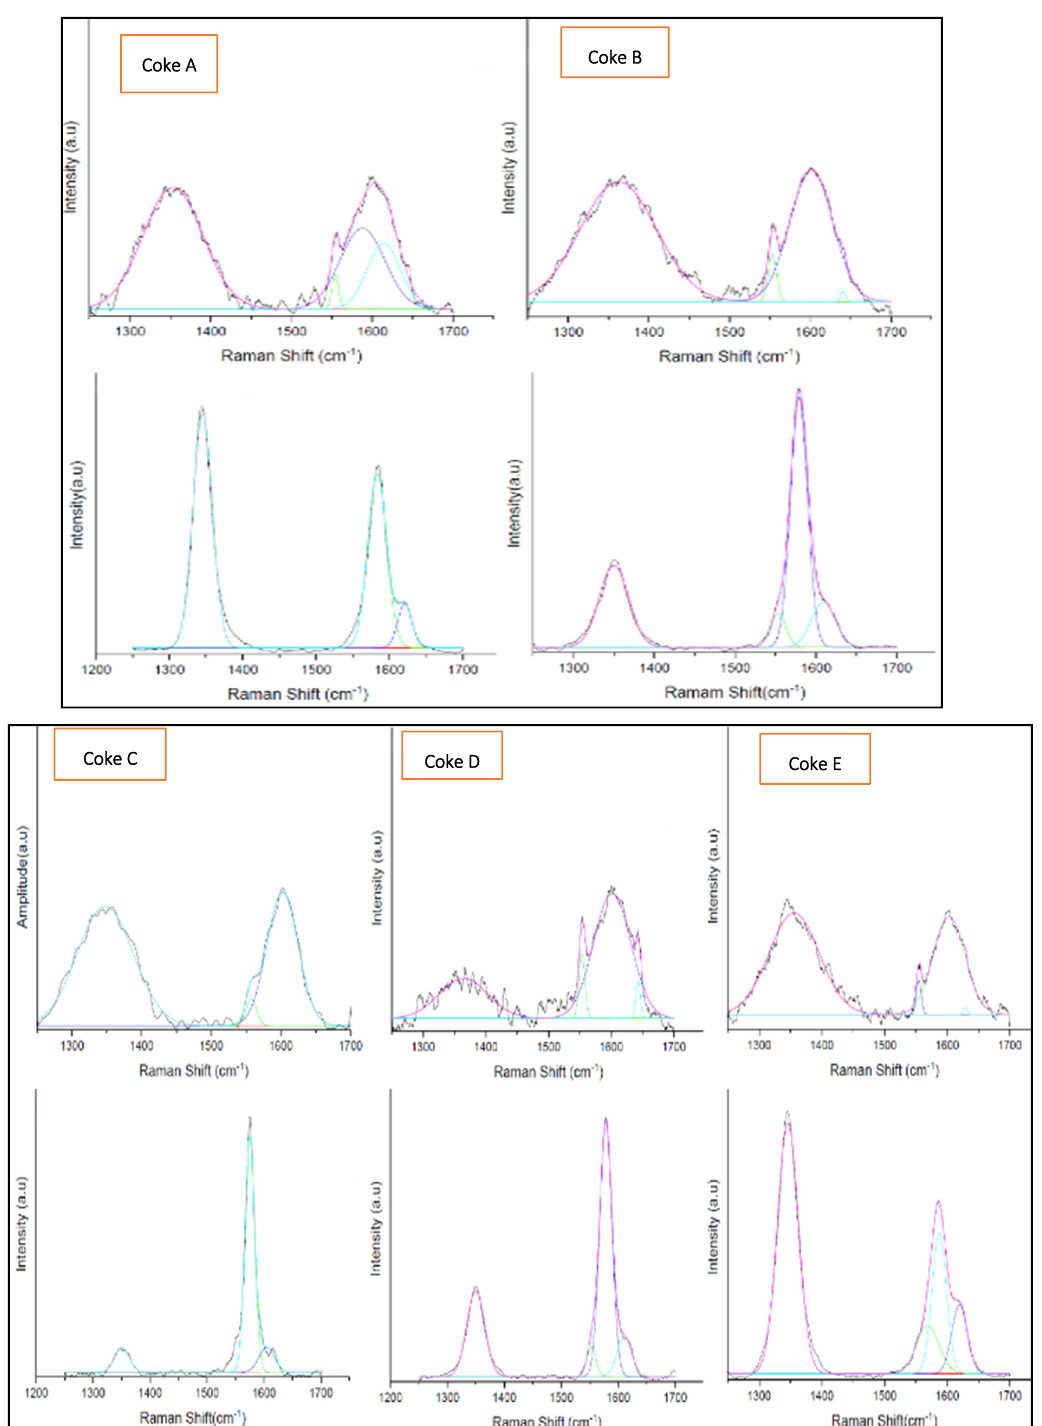
Figure 7. Comparison of the Raman spectra of all five coke types before and after heating to temperature up to 1600 ◦ C. Top row: before heating; bottom row: after heating. Continous curve is the original curve and the rest of the curves are deconvoluted curves of the various characteristics.